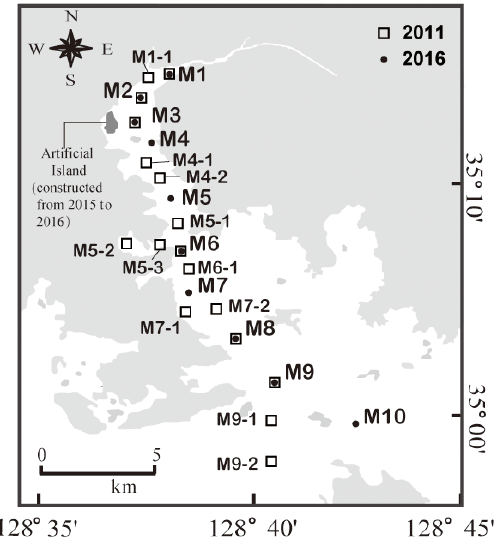
Figure 1. A map showing the sampling stations for DOC, δ 13 C- DOC, FDOM, and the DOC / DON ratio in Masan Bay, Republic of Korea, in 2011 and